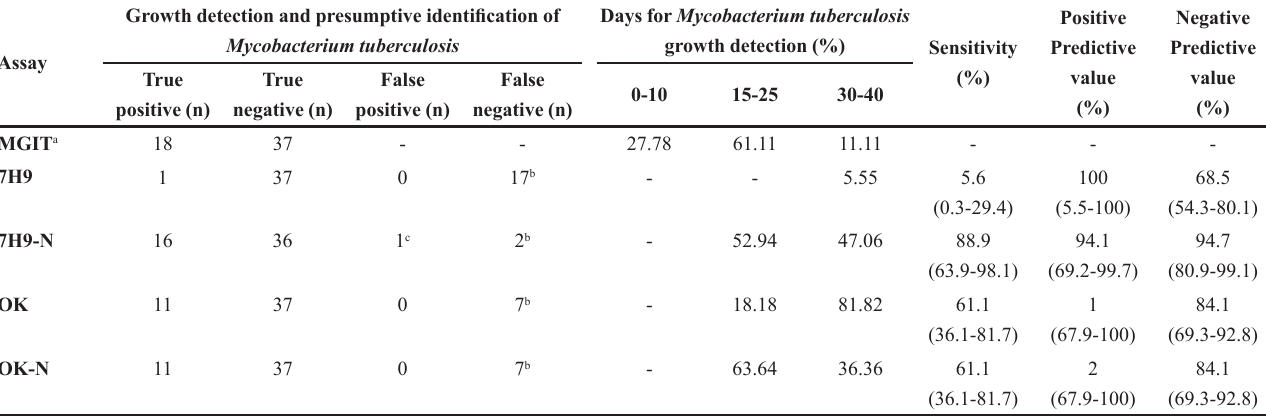
TABLE I - Comparison of media without (7H9 and OK) and supplemented by sodium nitrate (7H9-N and OK-N) with